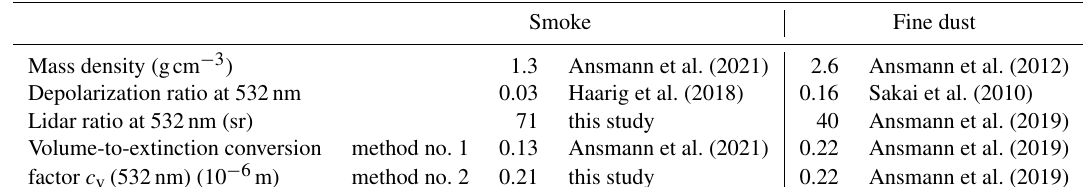
Table 4. Parameters required for the mass concentration retrieval, considering fine dust and smoke mixture.